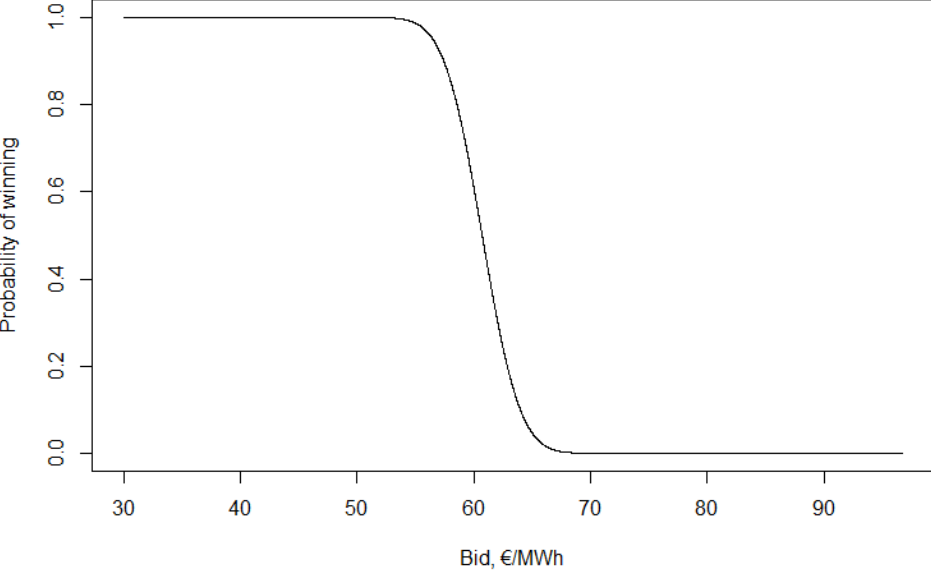
Figure A1. Probability of winning in case of different bids, assuming F 1 bid distribution, source: own figure.